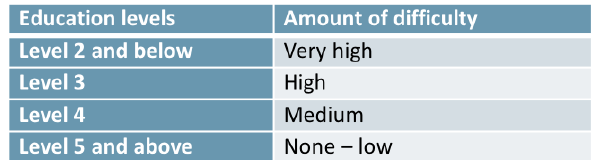
Table 5: Amount of diflculty related to education.